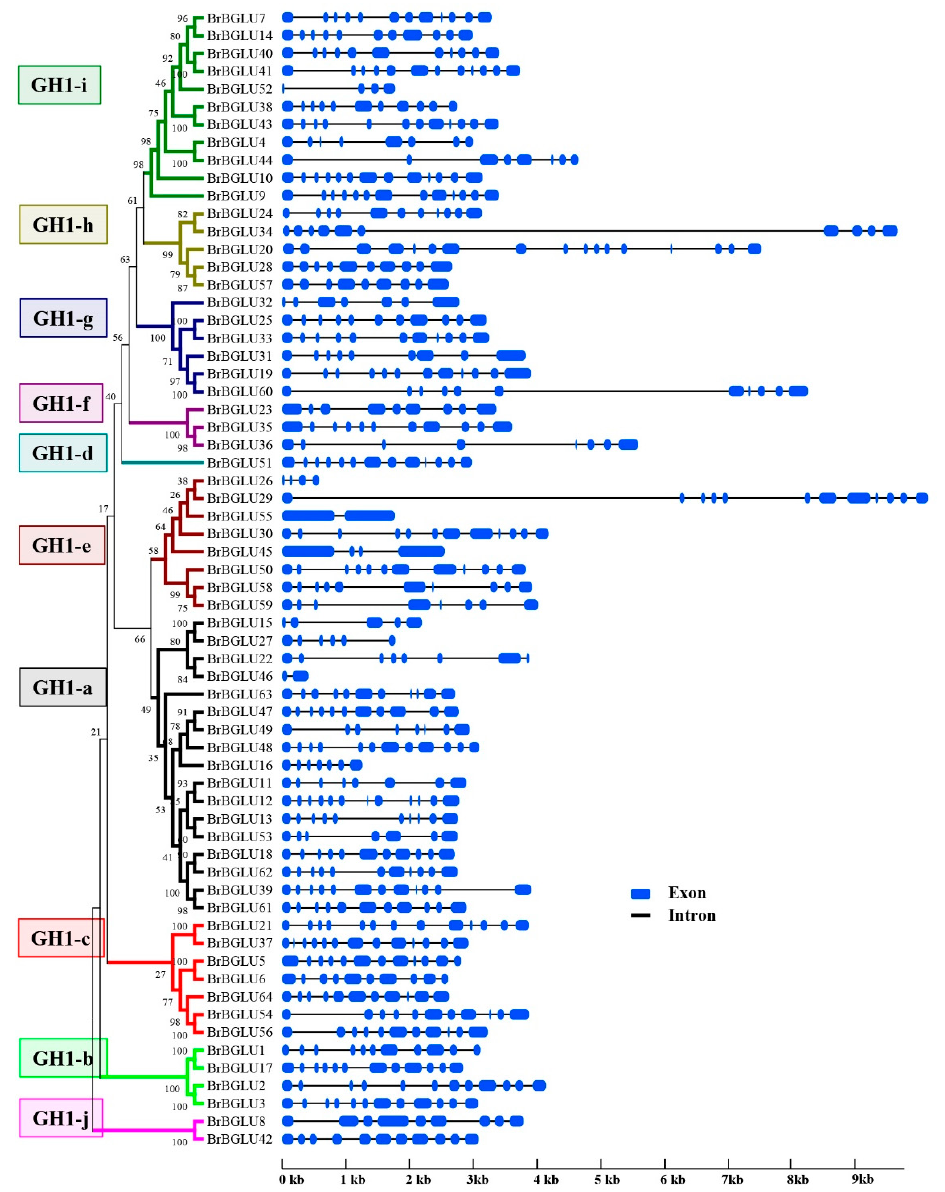
Figure 3. Exon–intron organization of BrBGLUs in different subgroups. Exons and introns are represented by blue boxes and black lines, respectively. The phylogenetic tree of each subfamily was constructed using MEGA6, as described in Figure